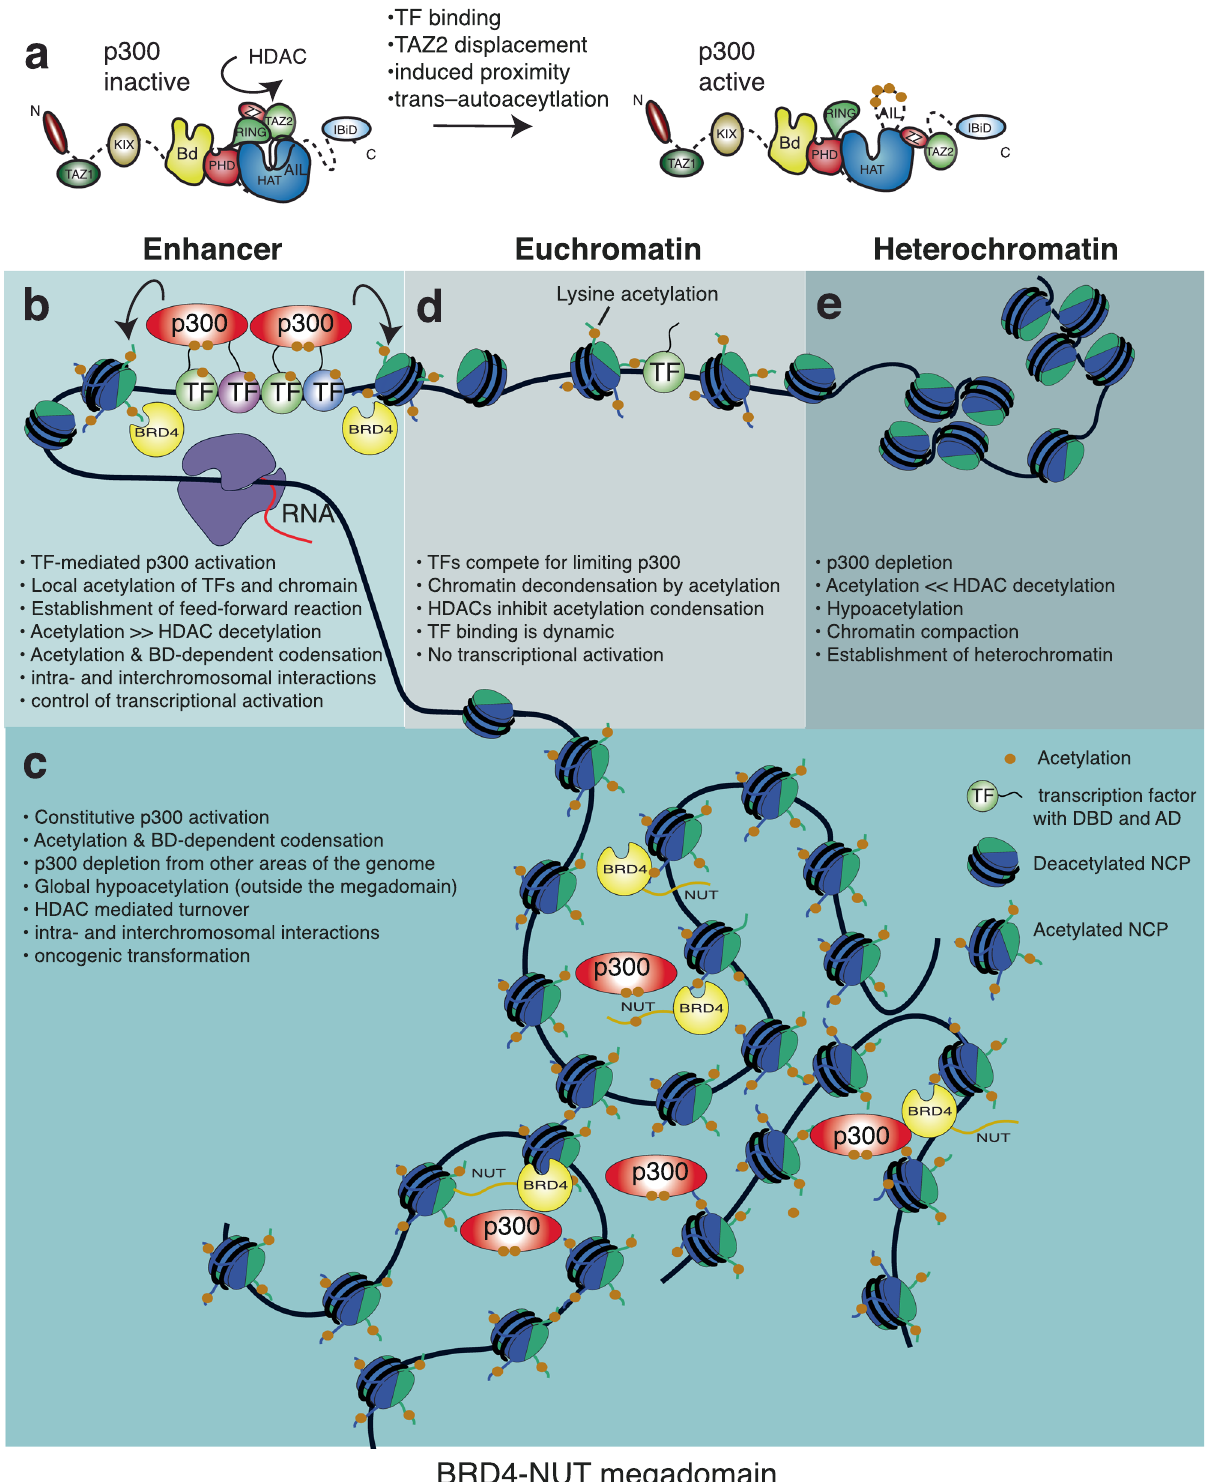
Fig. 7 | Molecular model for p300 activation in physiological setting and dis- ease. a p300 is maintained in the inactive state by HDACs. Activation requires TF bindingwhichresultsautoacetylationandremovalofautoinhibition. b Inenhancer signalling, TFs interact through their ADs with the different protein interaction domains of p300 which results in scaffolding of dynamic TF assemblies. Local TF and histone acetylation allows binding of BD containing proteins including BRD4 thus establishing positive feed-back. HDACs are located in these condensates and enabledynamicturnoverthusresultinginbistabilityandresponsetochangesinTF signalling. c In BRD4-NUT NMC, the acetylation-dependent reaction drives